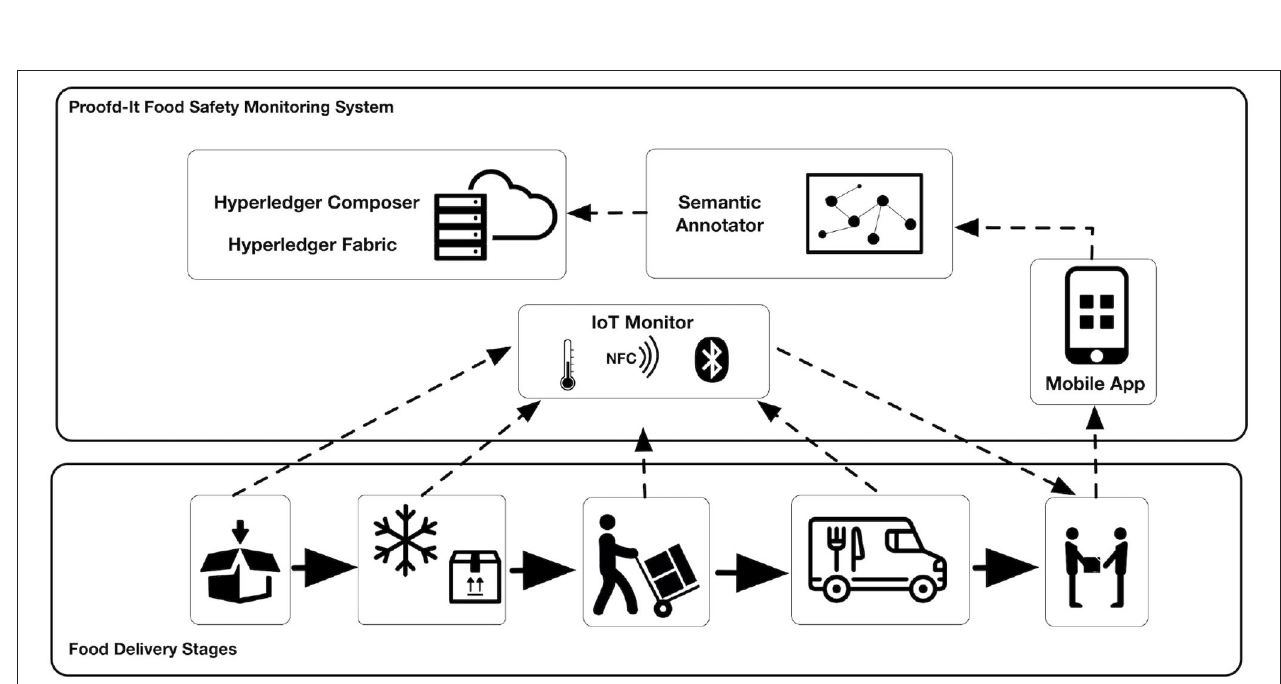
FIGURE 3 | A high level overview of the main components within the PROoFD-IT food safety monitoring system.